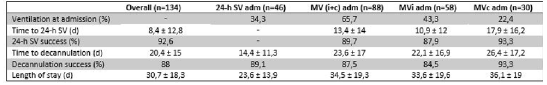
Table I Subgroup analysis. 24-h SV adm: 24-h spontaneous ventilation on admission; VM (i c) adm: mechanical ventilation (intermittent + tinuous) on admission; MVi adm: intermittent mechanical ventilation